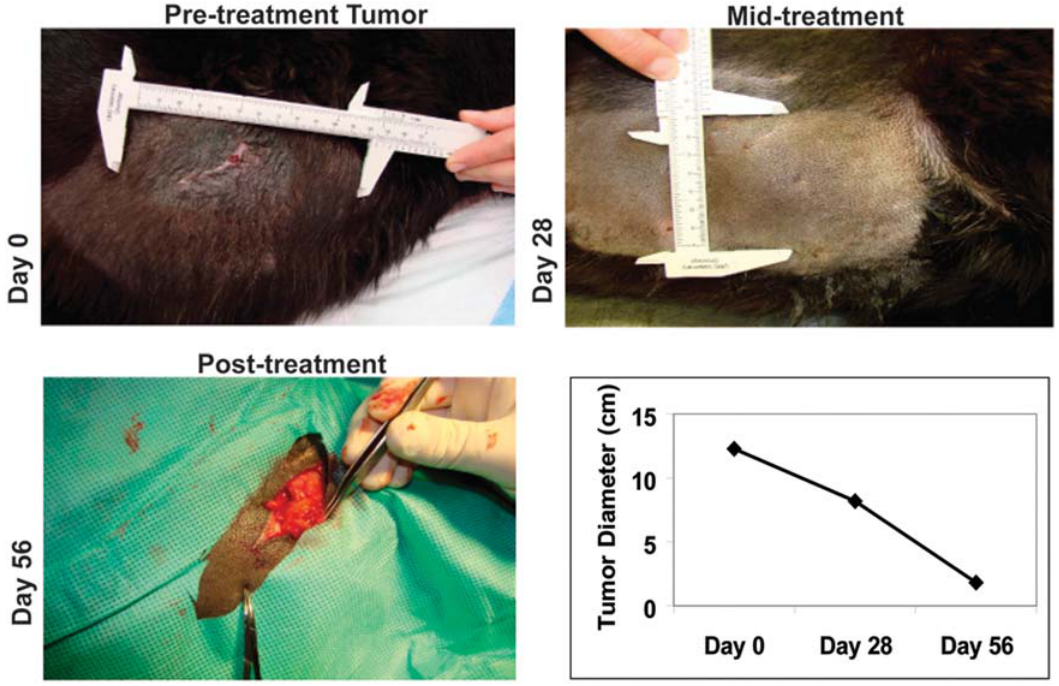
Figure 4. RGD-A- TNF administration resulted in objective tumor responses in dogs with spontaneous cancers. A large primary soft tissue sarcoma on the flank of Dog # 2.11 is shown to feature the potential magnitude of the tumor response. Prior to therapy (day 0), the tumor measured 12.3 cm in longest diameter. At day 28, after 4 weekly infusions of RGD-A- TNF , the tumor measured 8.2 cm in longest diameter (a 33% regression) and a RECIST-based partial response (PR). At day 56, after a total of 8 weekly systemic infusions of RGD-A- TNF , the tumor measured 1.85 cm in longest diameter prior to resection. Therefore, this response equated to an 85% regression from baseline and a continued clinical PR. Upon surgical resection of the residual lesion, no viable tumor was found and a pathological complete response was